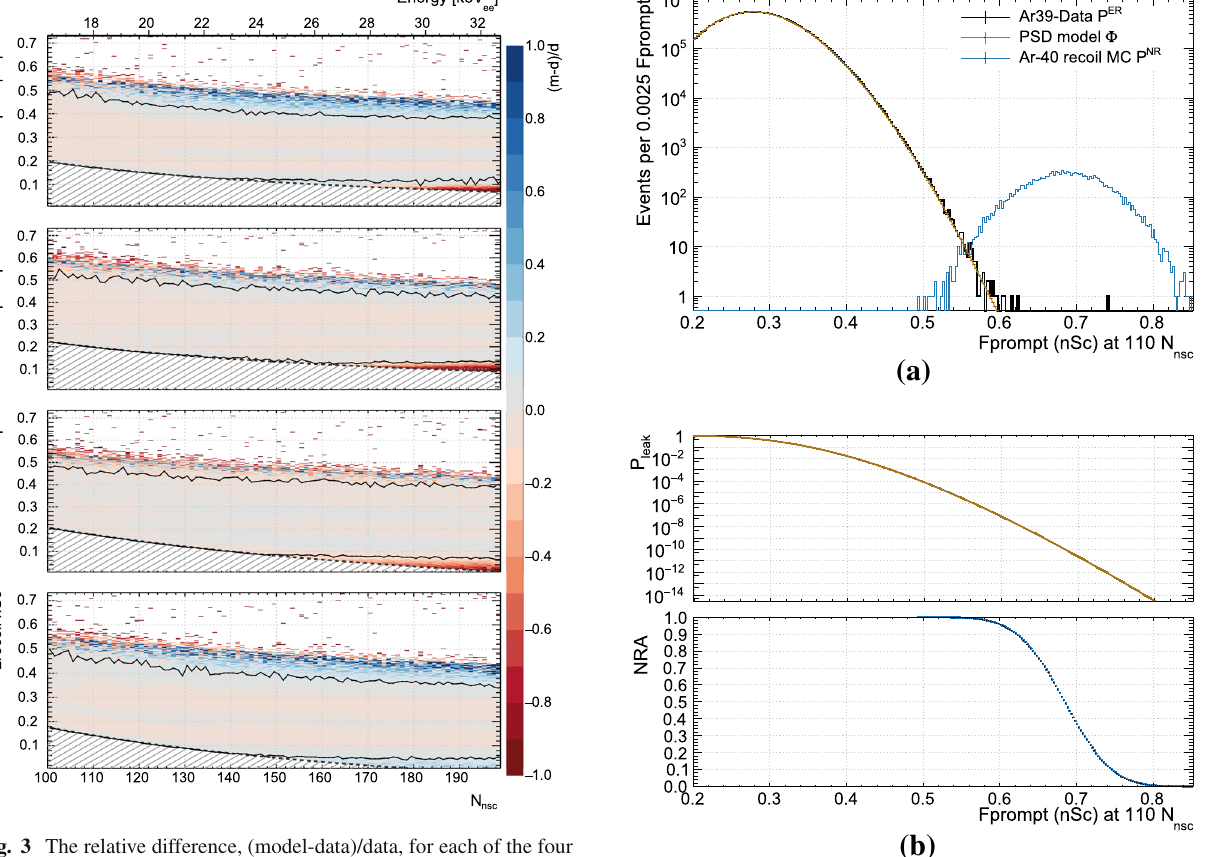
a pile-up event reconstructing at 130 PE and F prompt